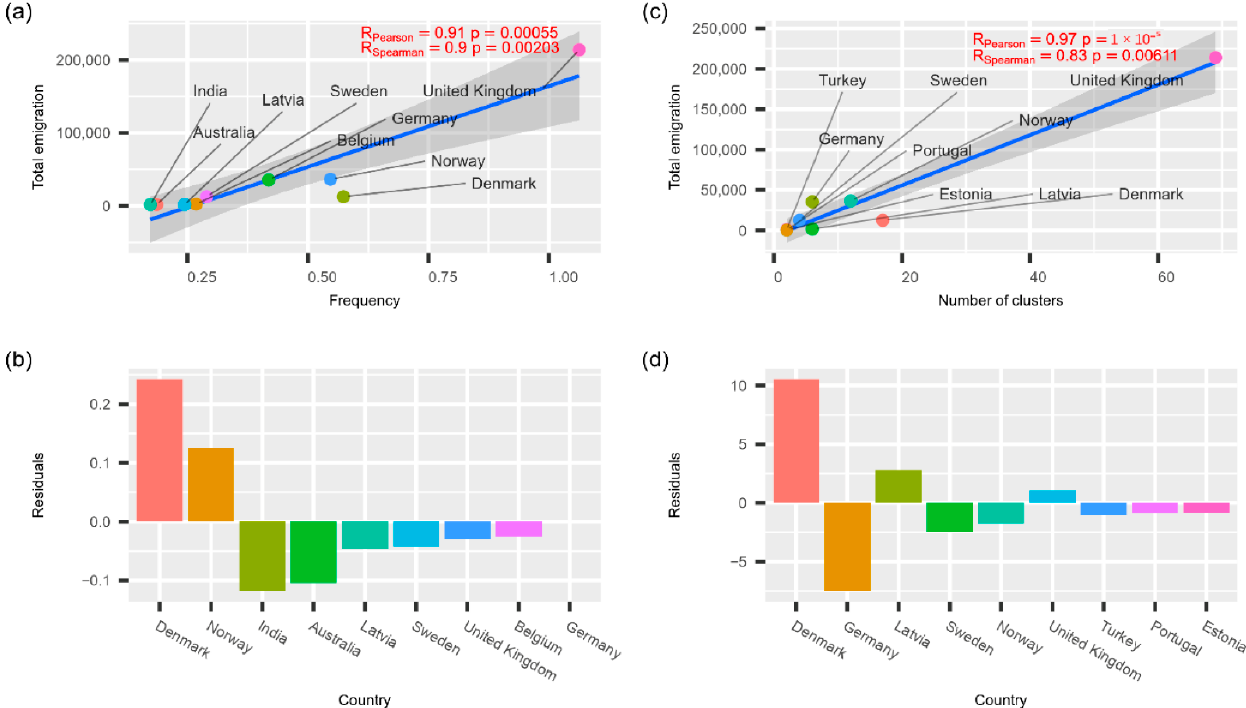
Figure 6 . Relationship between total emigration rate (data up to 2020) and potential country of origin, as deduced from the phylogenetic analysis. Plots ( a , b ) depict data based on transmission frequencies inferred from time-scaled phylogenies. Plots ( c , d ) depict corresponding data inferred from transmission cluster analysis. The residuals from the linear model in plots ( a , d ) are depicted in decreasing order. The transmission measures were summed across all analysed lineages before calculating the correlations.